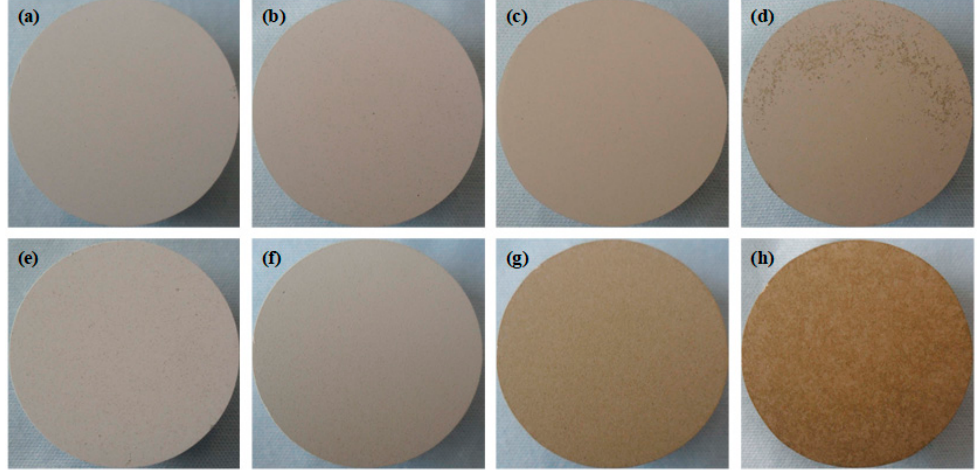
Figure 2. Macro images of micro-arc oxidation (MAO) samples with different V 2 O 5 contents: 0 g/L ( a , e ), 0.2 g/L ( b , f ), 0.5 g/L ( c , g ), and 0.8 g/L ( d , h ); under different loading voltages: 380 V ( a – d ) and 480 V ( e – h ).